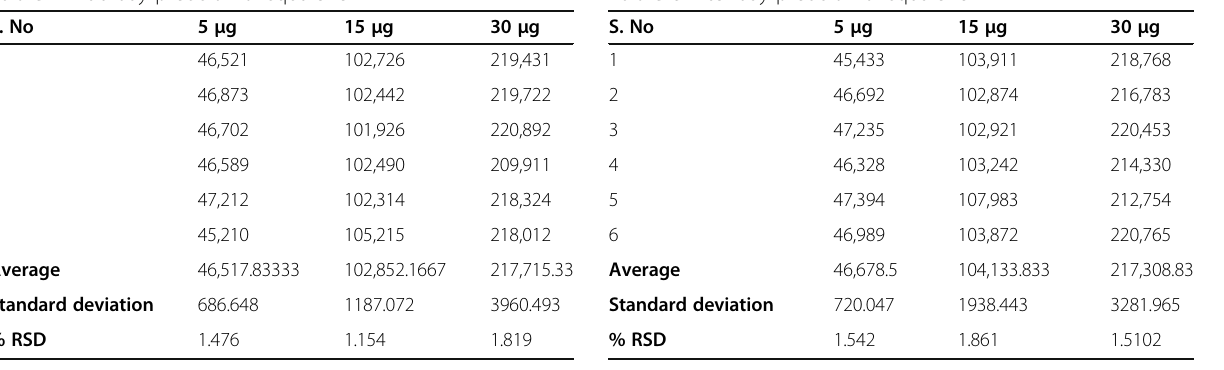
Table 7 Intra-day precision of squalene Table 8 Inter-day precision of squalene